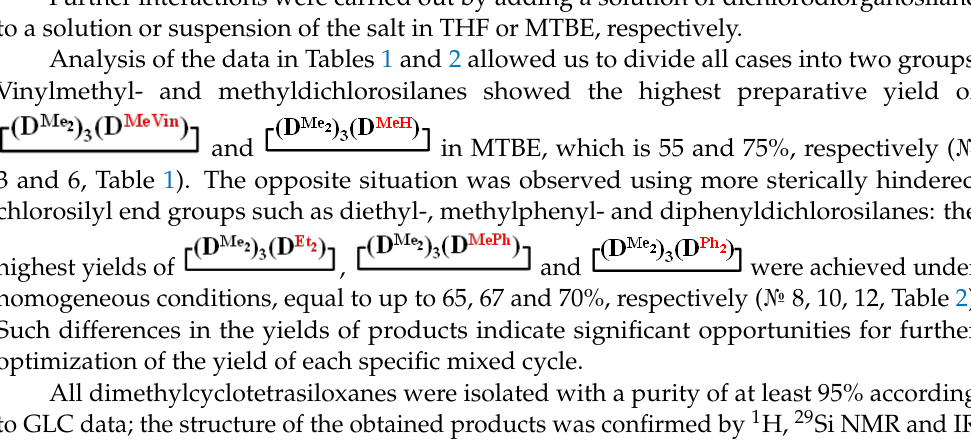
Figure 3. GPC curves of products 1, 2, 7 (Table 1).